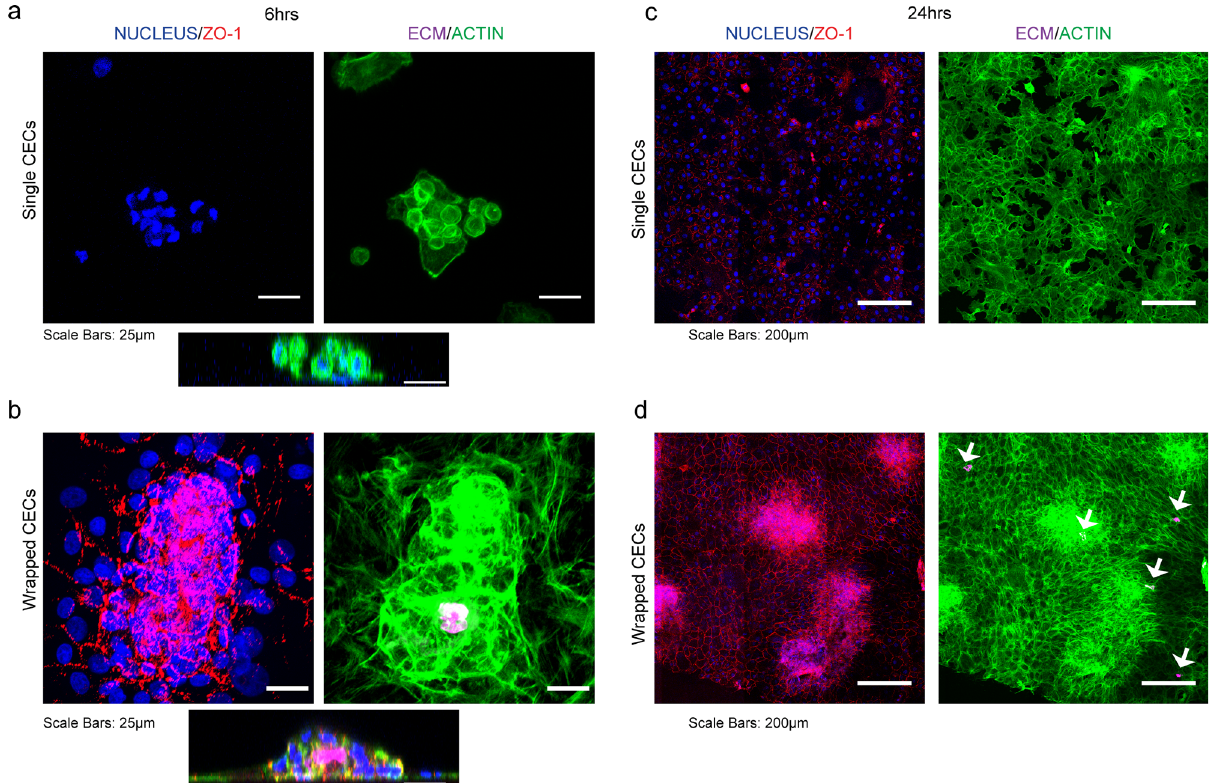
Fig. 3 Shrink-wrapped bovine CE cell μ Monolayers maintain ZO-1 expression and F-actin cytoskeleton as they grow out of the ECM scaffolds to form a monolayer on a collagen type I stromal mimic. a Six hours after reseeding onto a collagen type I gel, the single CE cells have no established F-actin cytoskeleton or ZO-1 expression. The cross-sectional view shows the rounded cell morphology. b In contrast, the CE cells in the shrink-wrapped μ Monolayers have maintained their ZO-1 expression and F-actin cytoskeleton, while growing out of the ECM scaffolds. The cells at the periphery of the shrink-wrapped CE cells are also expressing ZO-1. The cross-sectional view shows that the cells are spreading. c At 24hours, single CE cells have begun to spread and cover almost the entire scaffold. d At 24hours, the CE cells have already grown out of the ECM scaffolds and formed an almost complete monolayer. For a – d : Nucleus = blue, ZO-1 = red, ECM(COL4) = magenta, F-actin =